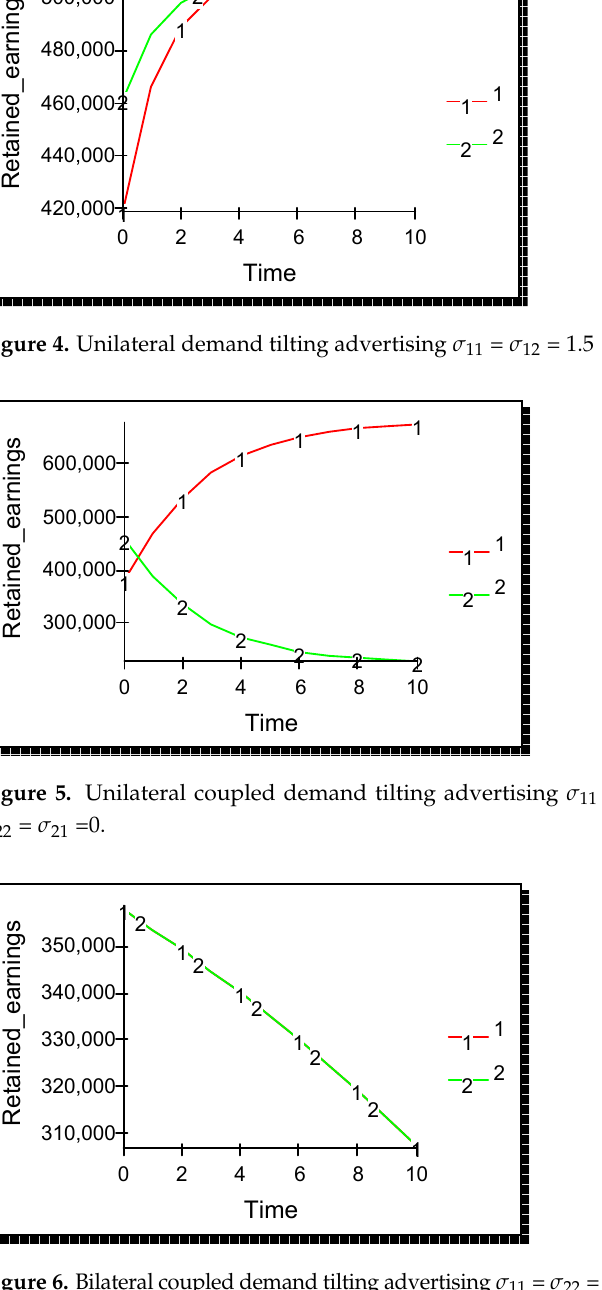
1 Figure 3. Bilateral demand tilting advertising σ 11 = σ 12 = σ 22 = σ 21 = 1.5 × 10 − 10 . 4.2. Scenario Two: One Firm Advertises So as to Tilt Upwards Both Its Own and Its Rival’s Demand Functions, the Rival Firm Does Not Advertise Some form of asymmetry is required for one firm to gain a competitive advantage over the other, for example, in market structure, cost structure, or advertising effectiveness. The effectiveness of advertising that induces horizontal differentiation is now allowed to become asymmetric. Figure 4 shows results when only one firm advertises, but this advertising has an equal impact on its own and on its rival’s demand. This is a case of perfectly cooperative spillover as follows: the rival firm gains from the firm’s advertising but does not bear any of the cost, consequently gaining a competitive advantage. This result suggests that, as is the case with cooperative shifting advertising,